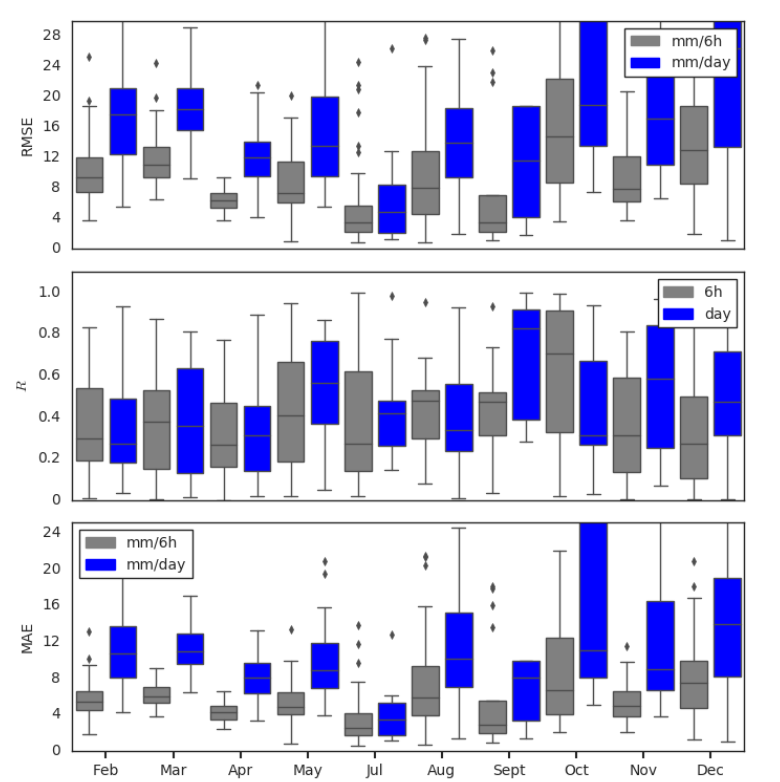
Figure 15. Standard validation scores for RF regression model (rain rate) against gauge stations. The scores are based on the data pairs of 6 h/daily for the time period from February 2017 to the end of 2017. The scores were calculated from the pairs in which rainy events from the RF model or gauge were available. The absolute value of R is shown here. The gray boxes indicate the results for stations with 6-h resolution, and the blue boxes for stations with daily resolution. Boxes show 25th, 50th, and 75th percentiles. Whiskers extend to the most extreme data point between 75th and 25th percentile. Outliers are shown as